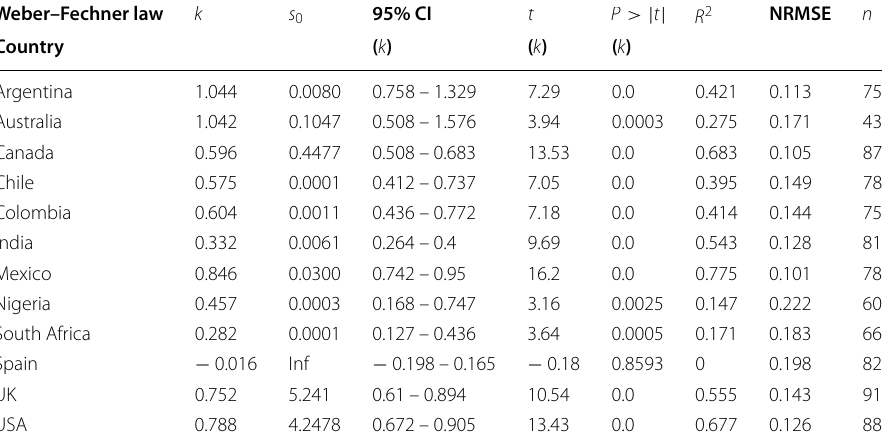
Table 3 Results from the fit of the Weber–Fechner law [see Eq. (10)] to the observed relationship between the Death NLS and the logarithm of the daily number of deaths in each country (see Fig.